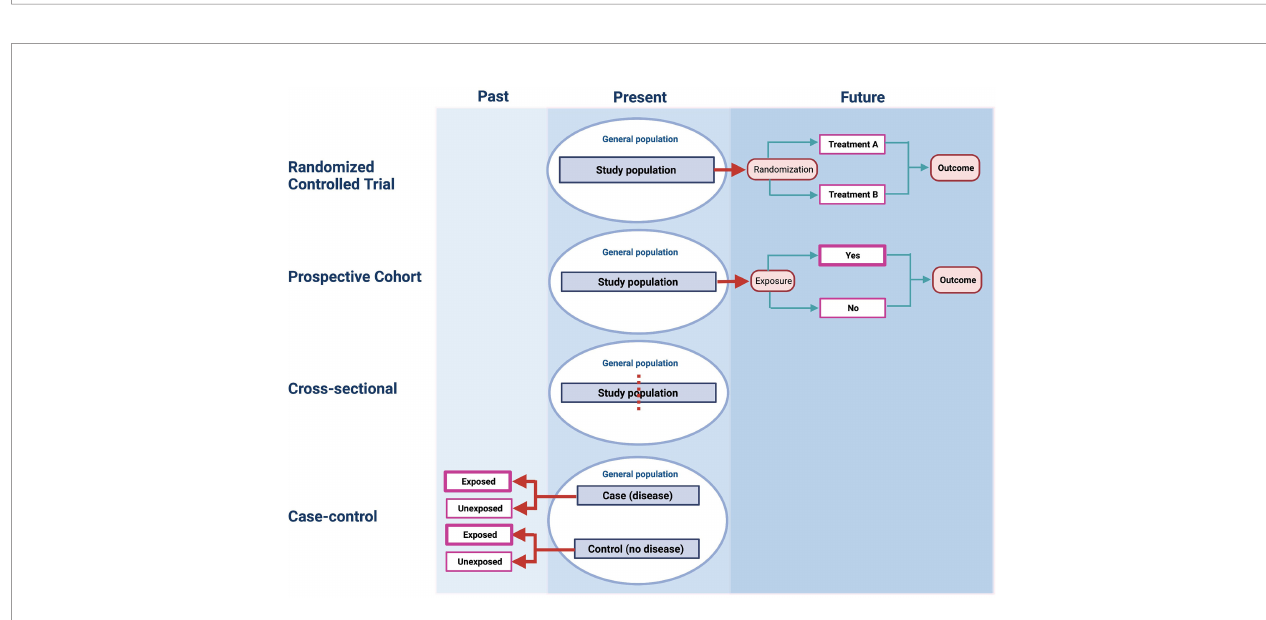
FIGURE 1 | Adapted from Lancet . Grimes DA, and Schulz KF. An overview of clinical research: the lay of the land:57 – 61, 2002.